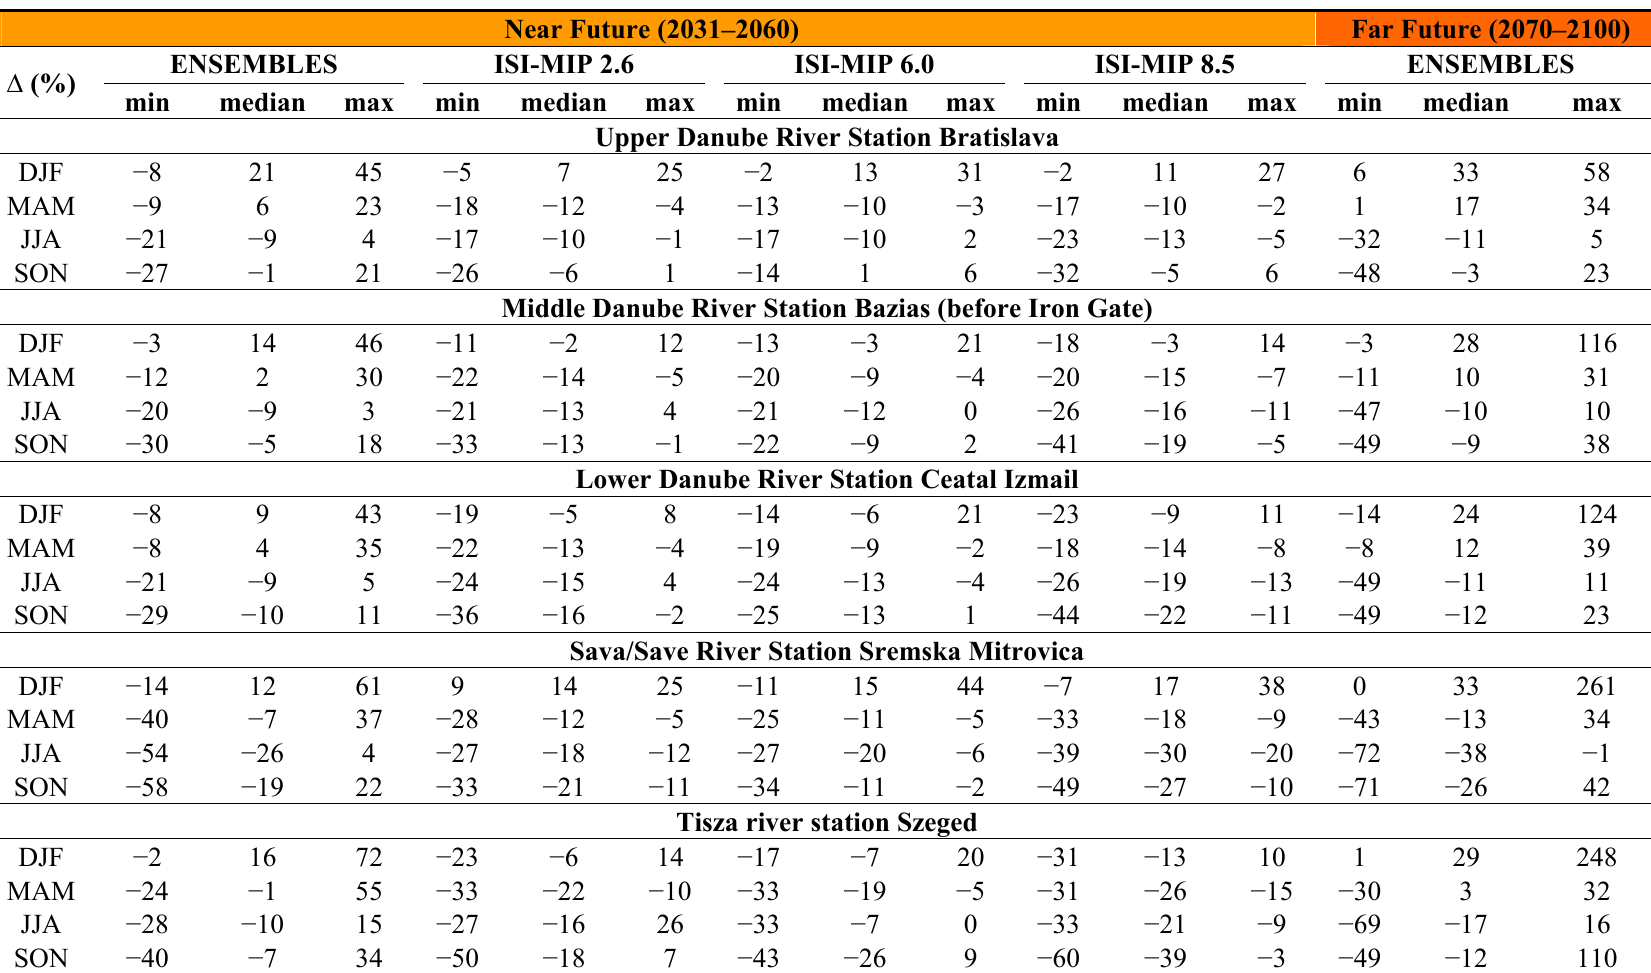
Table 2. Changes in seasonal river runoff in (%) under two multi-model sets relative to the reference period 1971–2000 for different river stations and the scenario periods 2031–2060 and 2070–2100. The changes are shown for the winter (December to February, DJF), spring (March to May, MAM), summer (June to August, JJA) and autumn (September to November, SON) months. The ENSEMBLES projections relate to the same global warming level as the ISI-MIP